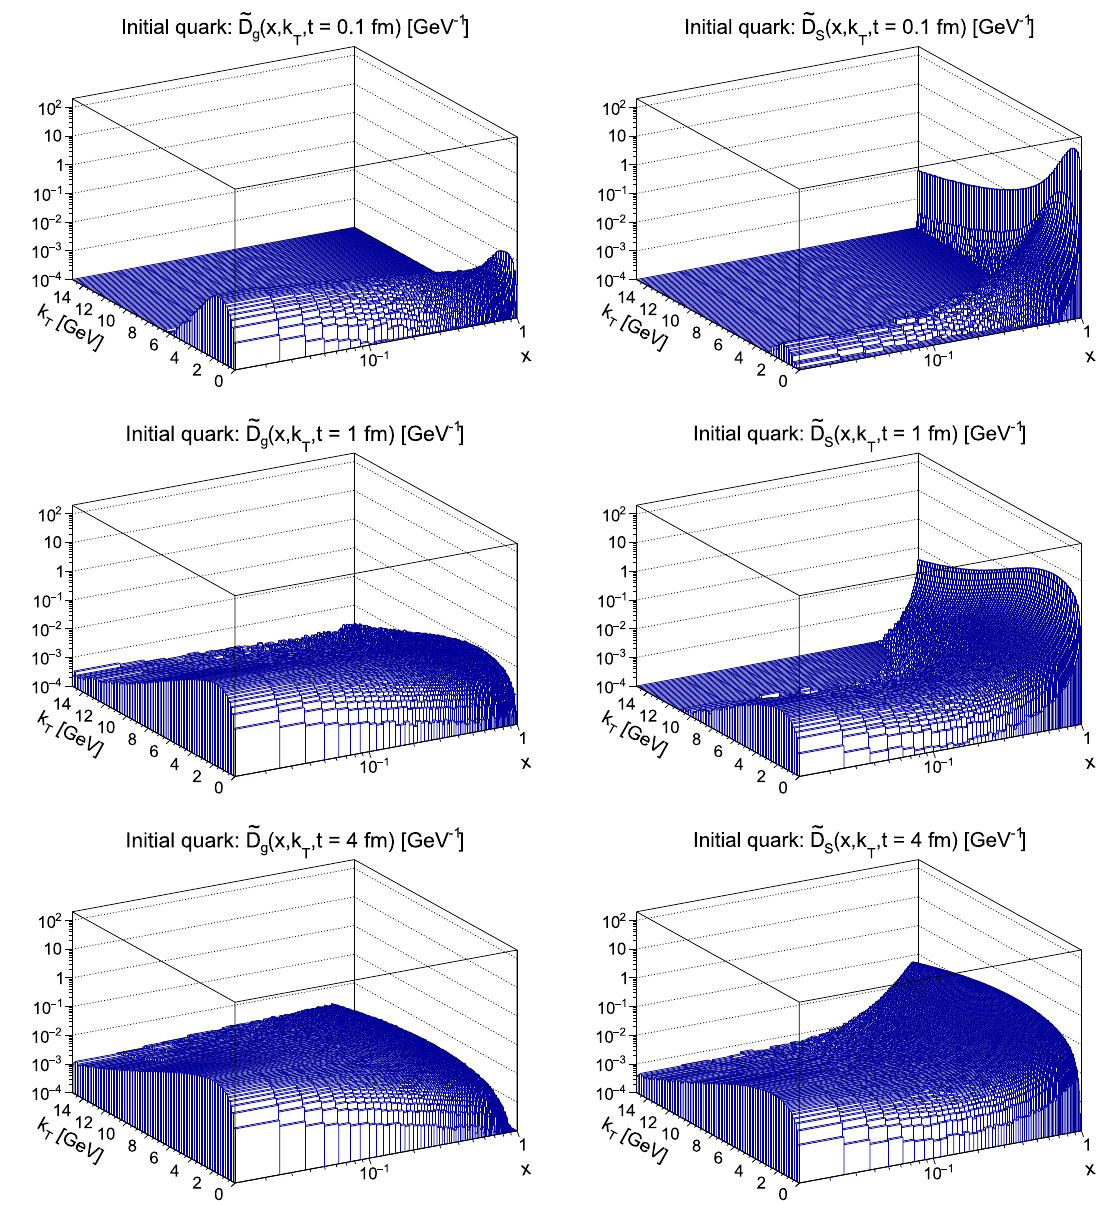
+ l 2 ) ] at the time-scales D